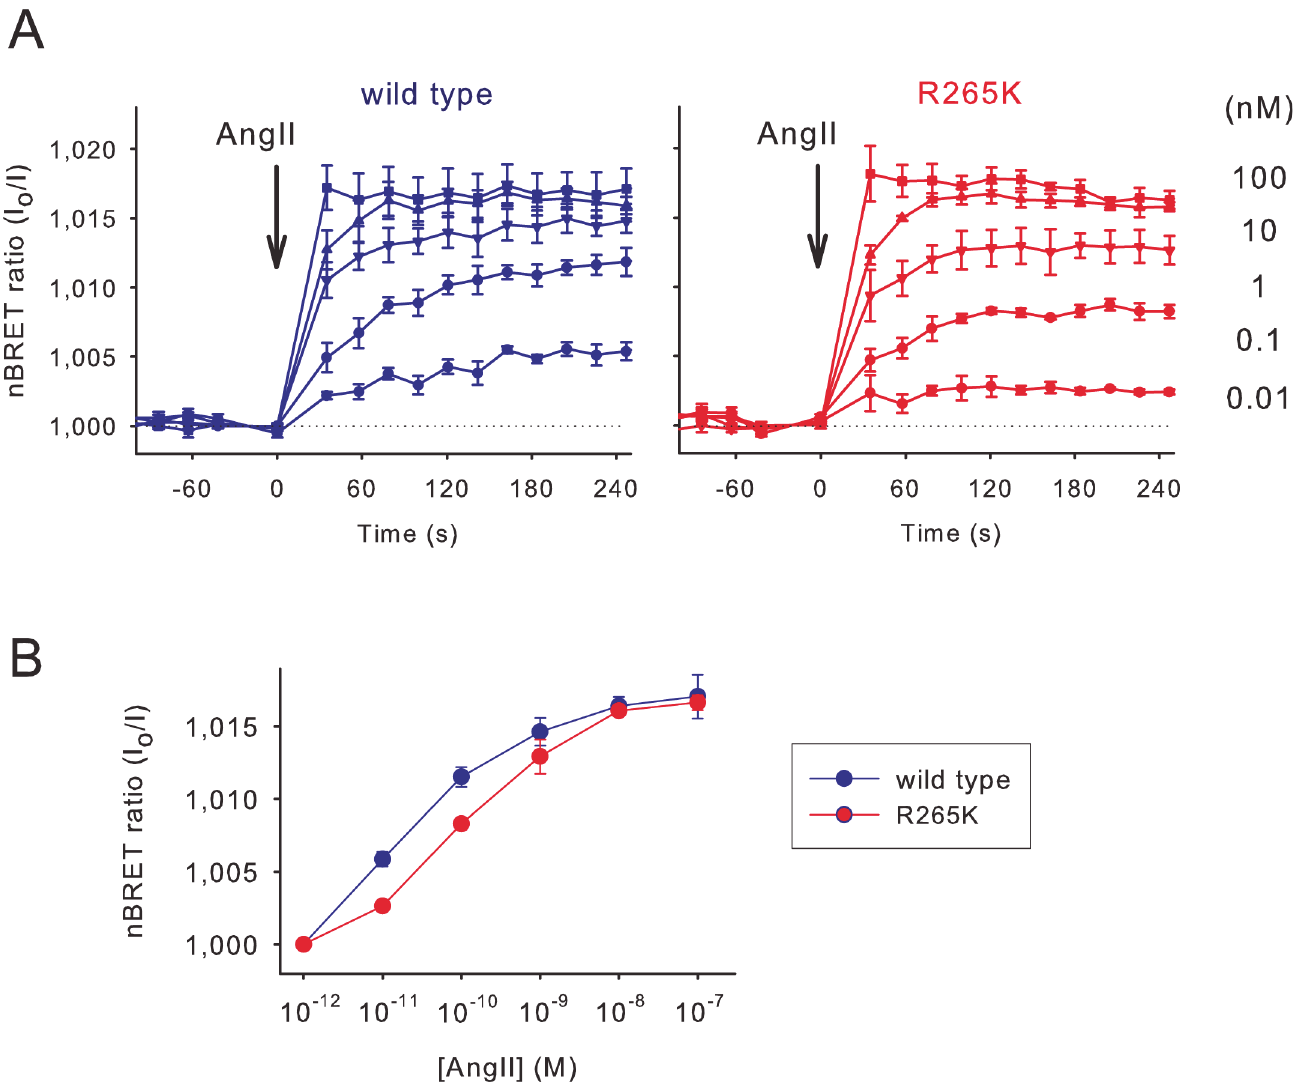
Fig 2. Comparison of the activation properties of the wild type and low-affinity Ins P 3 sensors. (A) Normalized BRET ratio (reciprocal of I/I 0 ) measured in HEK 293T cells transiently transfected with the AT1 angiotensin receptor and the wild type or R265K mutant Ins P 3 biosensors upon Ang II stimulation (10 -12 -10 -7 M) added manually. To avoid desensitization of the receptor a non-internalizing receptor was used (AT1R- Δ 319). Error bars show standard error values from three independent measurements performed in triplicate. (B) Concentration-response curves for Ang II. Ins P 3 responses were measured 5 minutes after stimulation. The right shift caused by the R265K mutation corresponds to the lower ligand binding affinity of the Ins P 3